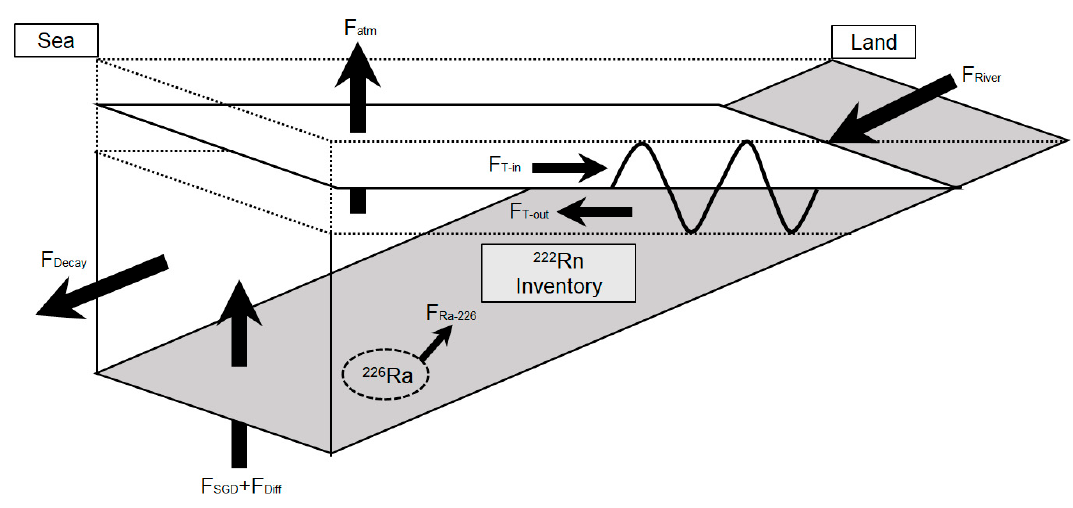
Figure 7. A synoptic diagram of the 222 Rn mass balance model in the Gaomei Wetland.